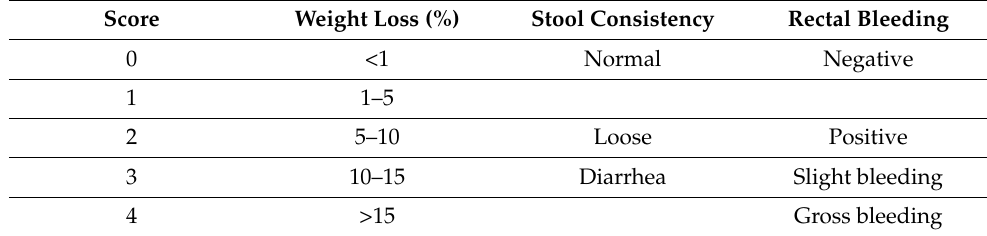
Table 1. Disease activity index (DAI)